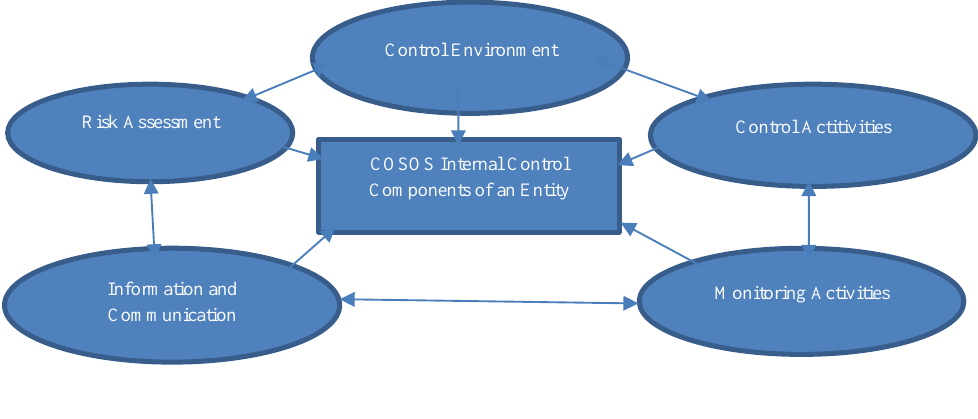
Figure 1: IC Framework; Source: Sketch based on COSO framework by researchers